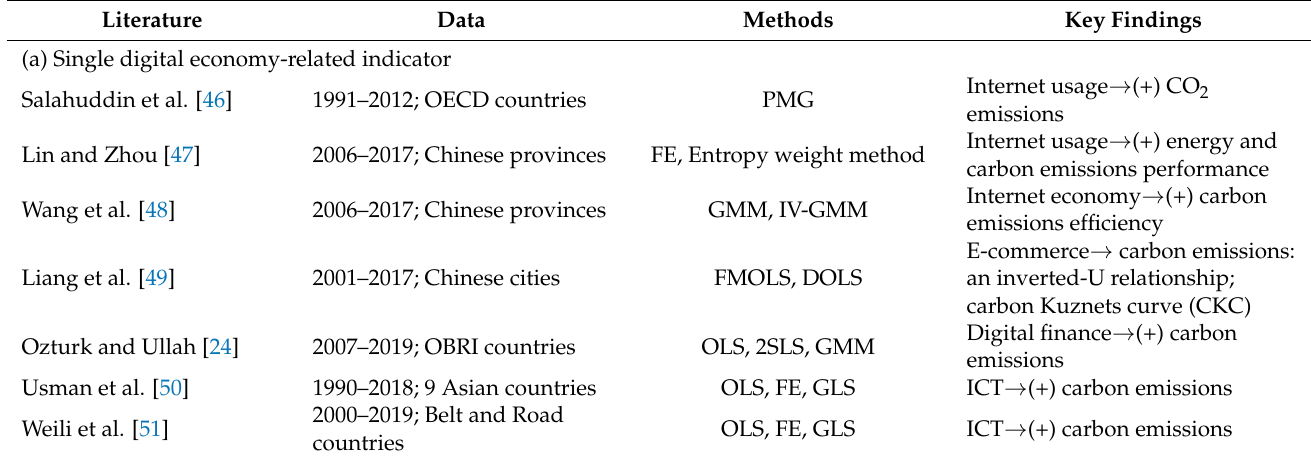
Table 1. Studies on the relationship between digital economy and environmental